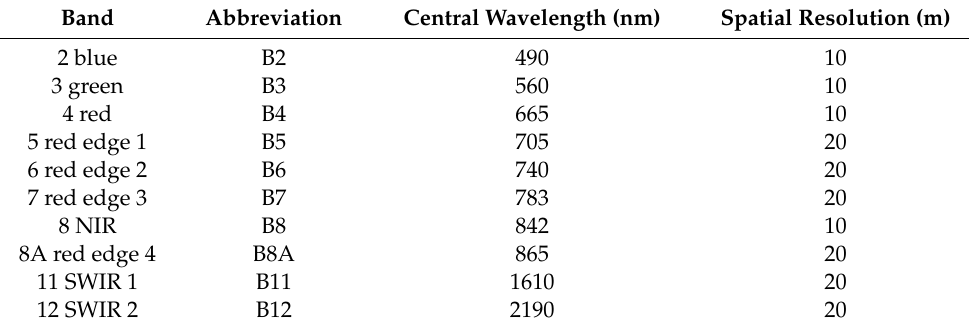
Table 2. The central wavelength and spatial resolution for Sentinel-2 bands used in this study. NIR represents near infrared and SWIR represents short wave